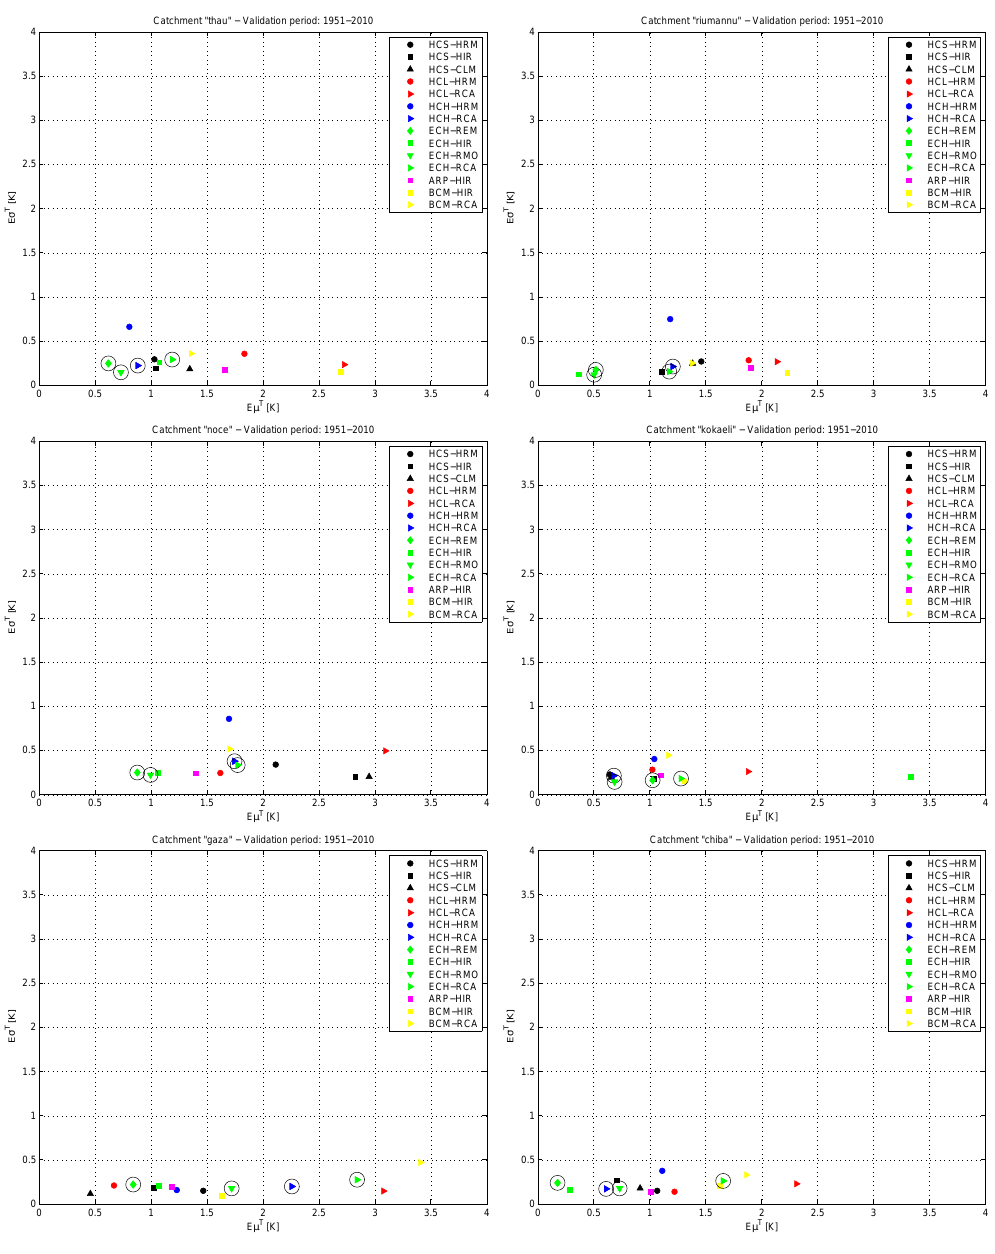
Fig. 6. Same as Fig. 5, but for temperatures (K) reduced to sea level.